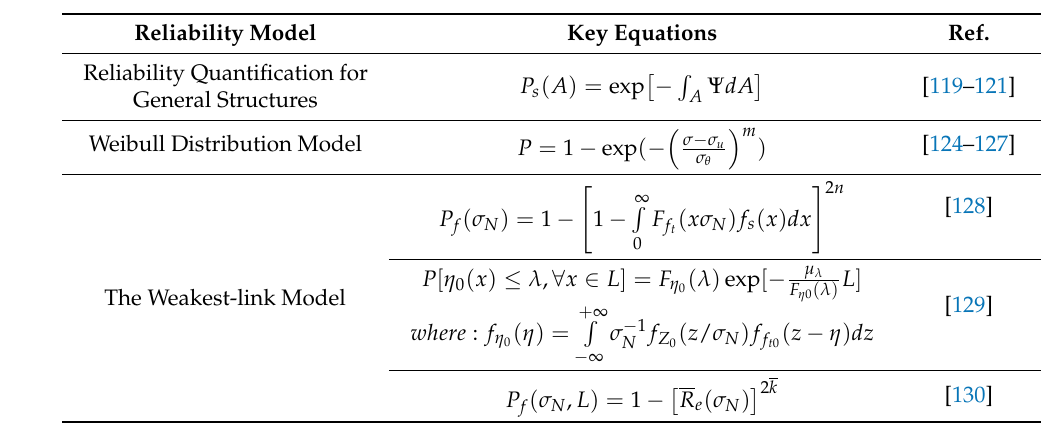
Table 5. Reliability quantification model of